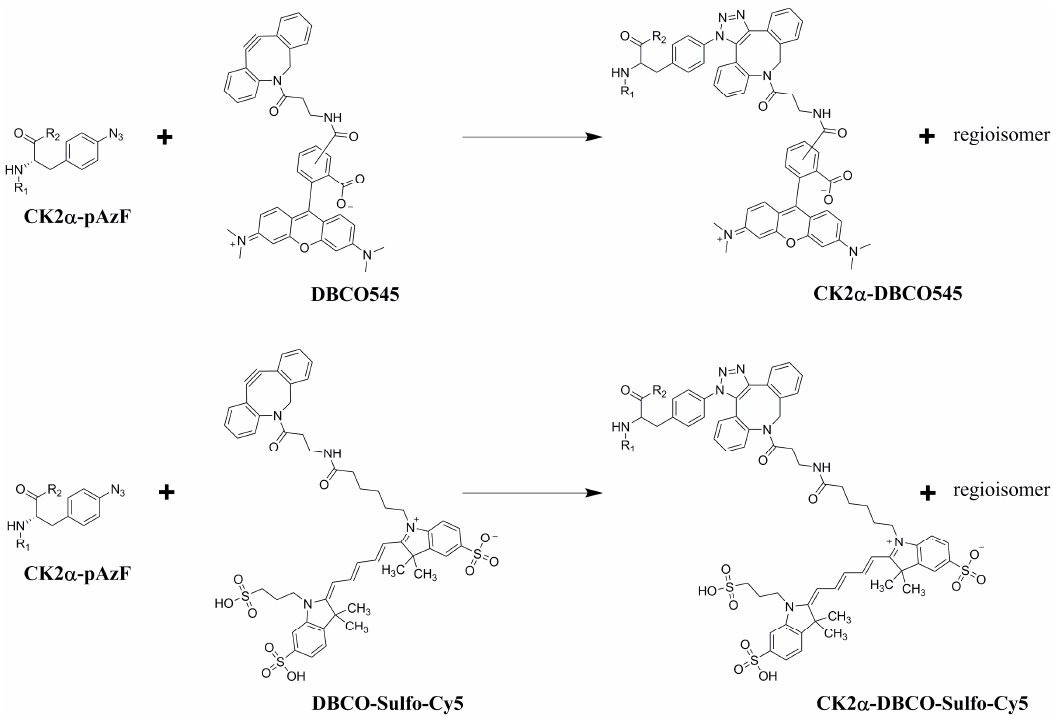
Figure 4. SPAAC click reaction of CK2 α -pAzF with the two dibenzylcyclooctyne-fluorophores DBCO545 and DBCO-Sulfo -Cy5, respectively (R 1 = N-terminal sequence of CK2 α -pAzF, R 2 = C-terminal sequence of CK2 α -pAzF). For both cases, beside the regioisomer 1,4 as shown in the reaction scheme, the regioisomer 1,5 can be obtained as well.